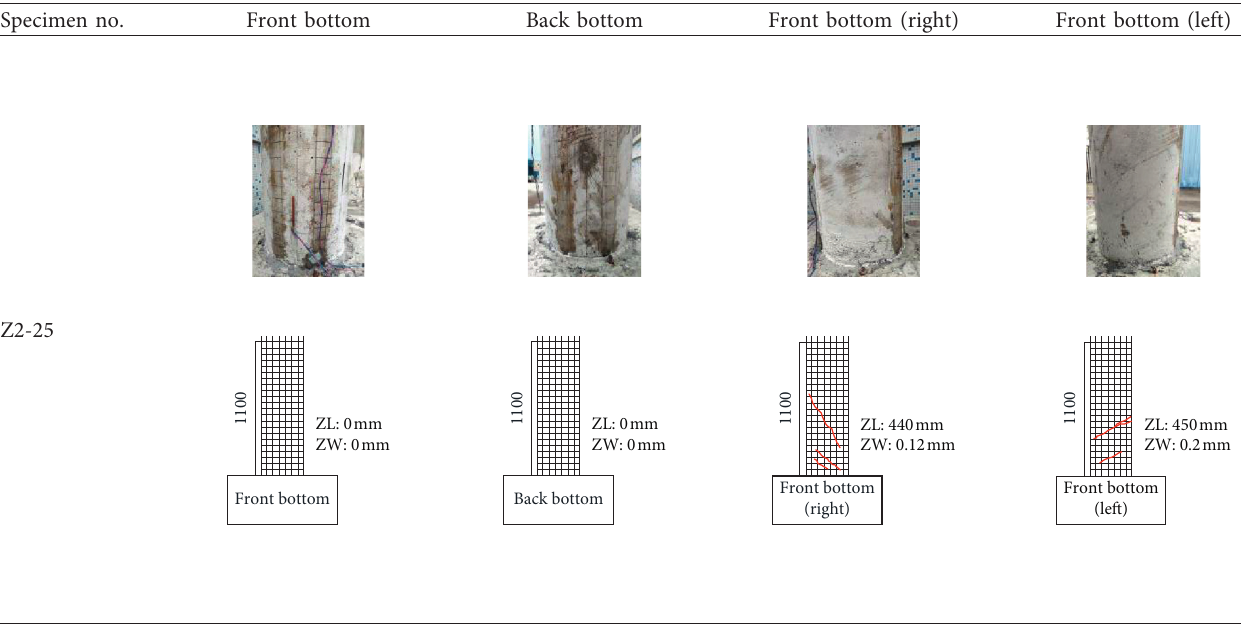
Table 12: Number, length, and maximum width of cracks in the lower area of the front of the specimens under different energies. 1 st Height of drop hammer (m)